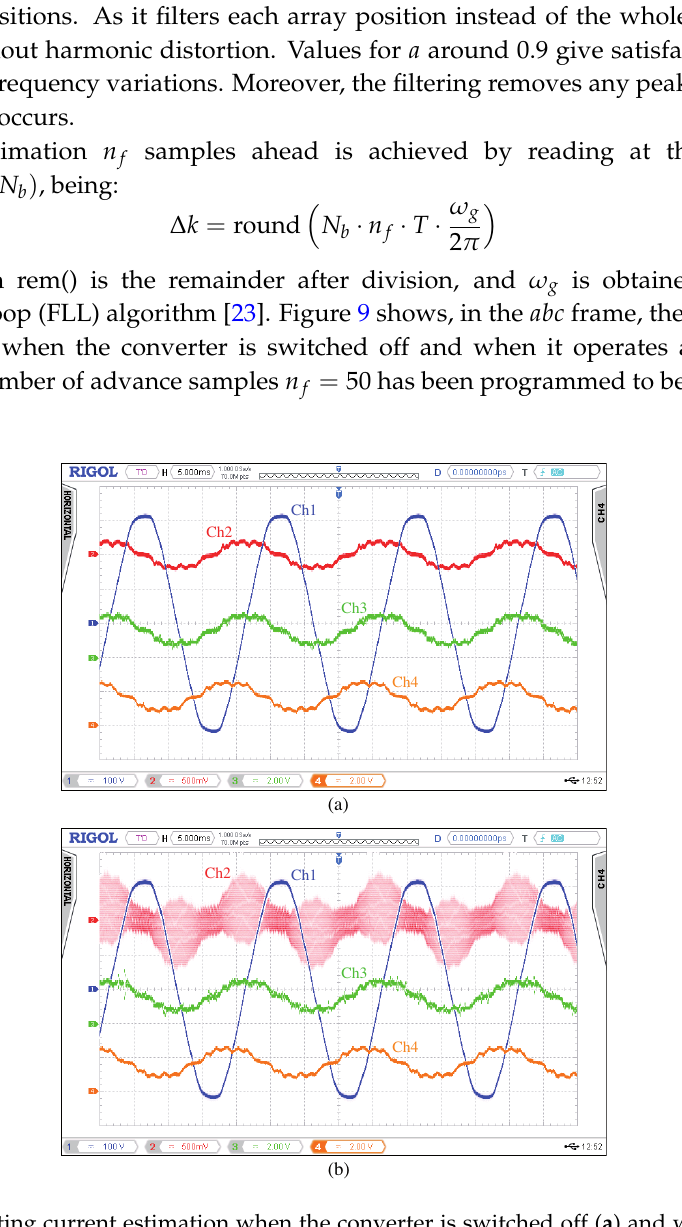
Figure 9. Distorting current estimation when the converter is switched off ( a ) and when operating at nominal power ( b ). Shown are: the grid voltage (Ch1), the current of the LCL capacitor (Ch2: 5A/div), the distorting current estimation without filtering (Ch3) and the filtered estimation 50 samples ahead